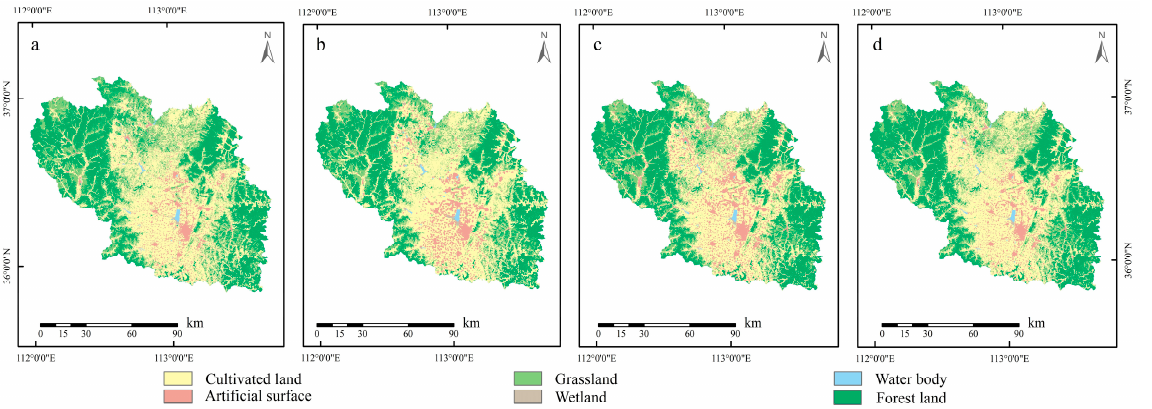
Figure 8. Observed ( a ) and simulated ( b ) land use and land cover (LULC) in 2020, natural development ( c ) and conservation development ( d ) land use and land cover (LULC) in 2030.